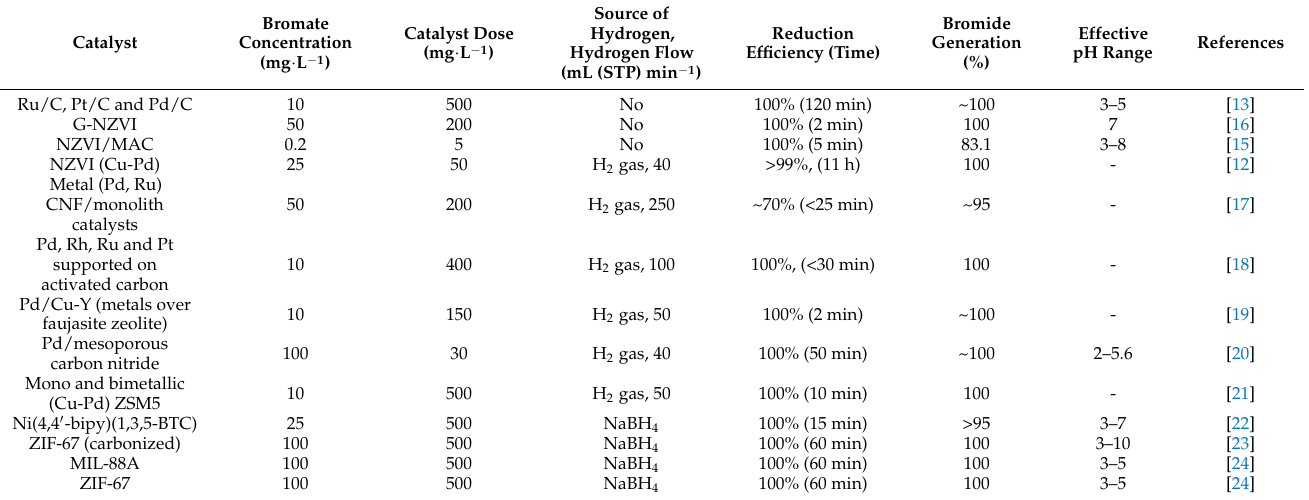
Table 1. The reactivity of different nanoscale heterogeneous catalysts for the reduction of aque- ous BrO 3 −